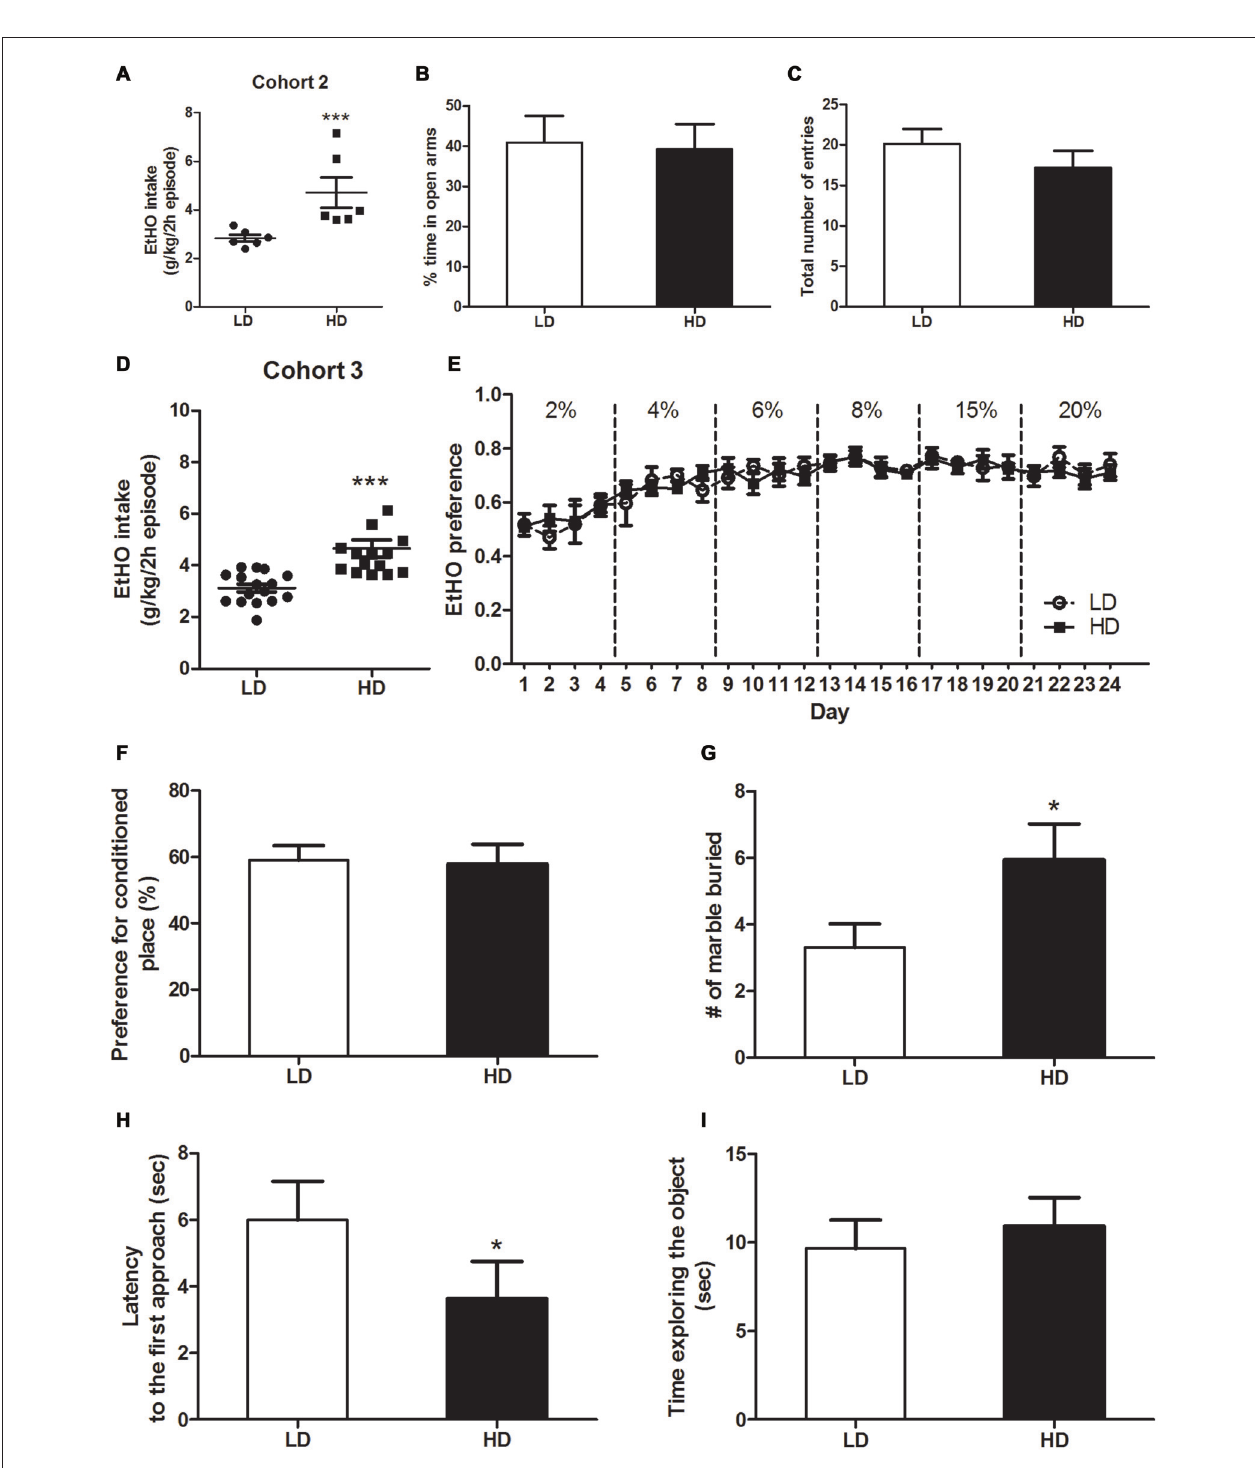
FIGURE 2 | Individual consumption of 20% (v/v) EtOH during a single 2 h episode of DID, from which high vs. low drinkers (HD/LD) subpopulations were identified [Cohort 2] (A) . Basal anxiety-like responses in HD/LD, as measured by elevated plus maze (EPM) (B,C) . Individual consumption of 20% (v/v) EtOH during a single 2 h episode of DID, from which HD/LD subpopulations were identified [Cohort 3] (D) ; EtOH preference data over 6 progressively increasing EtOH concentrations by HD/LD, in a 2-bottle free choice procedure (E) . Preference (%) for the chamber conditioned to EtOH after 4 EtOH conditioning trials in a conditioned place preference (CPP) procedure by HD/LD (F) . Number of marbles buried (G) latency to approach (H) and time exploring (I) a novel object in HD/LD subpopulations. Behavioral tests were conducted after 10 days without EtOH after the DID test. All values are means ± SEM. ∗ p < 0.05 and ∗∗∗ p < 0.001.